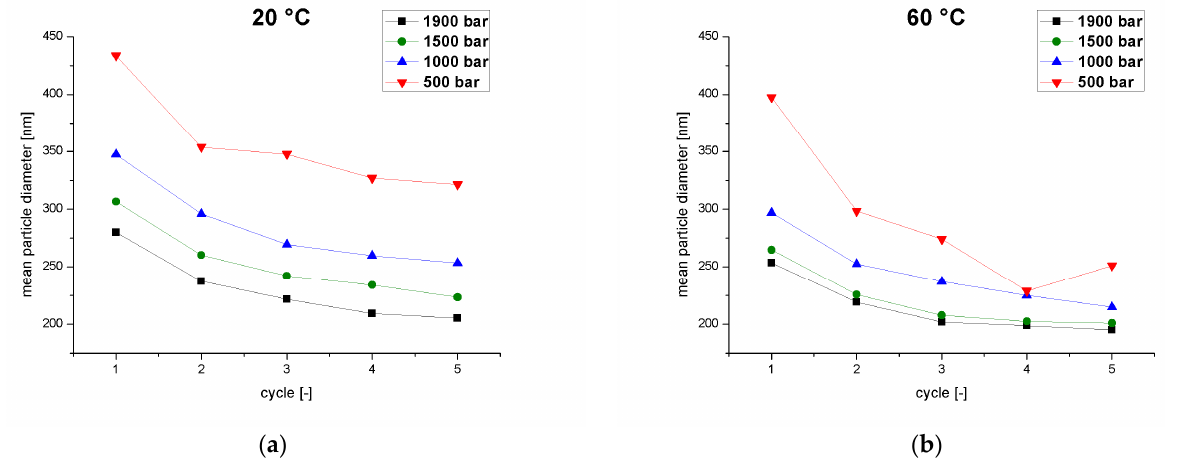
Figure 3. The mean particle diameter as a function of the number of cycles at different operating pressures (500–1900 bar) and two temperatures. ( a ) Emulsion temperature at the inlet of the homogenizer = 20°C. ( b ) Emulsion temperature at the inlet of the homogenizer = 60°C. The pFAT5 threshold is specified as ≤ 0.05% in USP Chapter 729 (Globule Size Distri- Various mechanisms of coalescence are described in the literature [33]. For the bution in Lipid Injectable Emulsions) [24].A study of the preparation of a soybean oil 25 °C showed no significant decrease in the pFAT5 value (0.01–0.02%) from cycles 6 to 10,